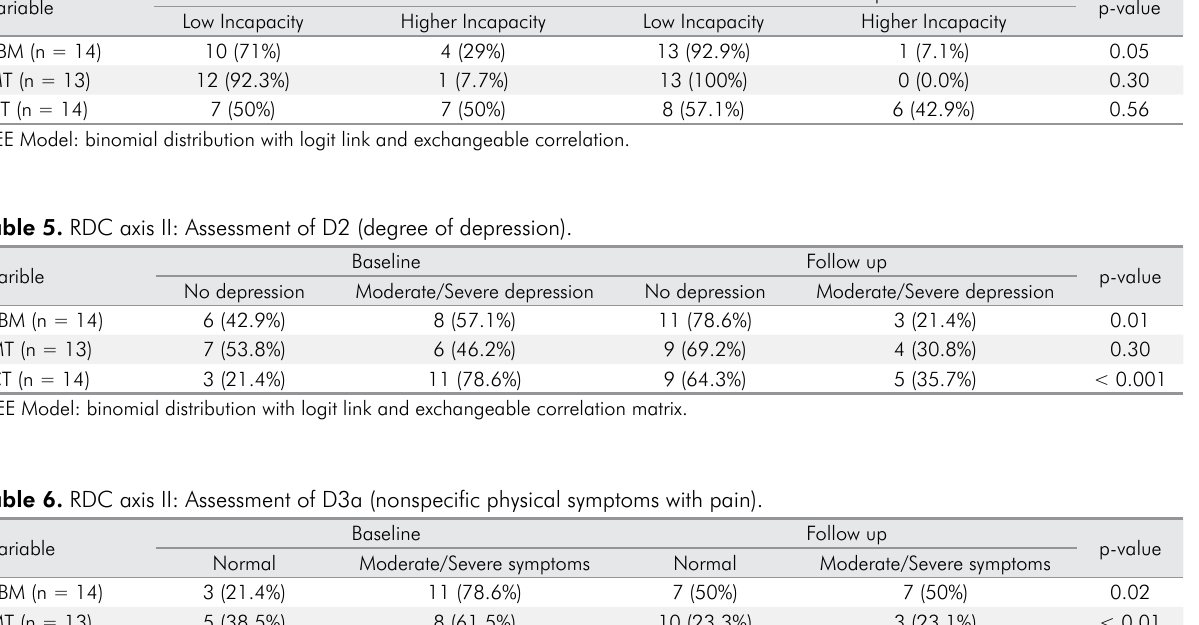
Table 4. RDC axis II: Assessment of D1 (intensity of chronic pain and disability). Variable